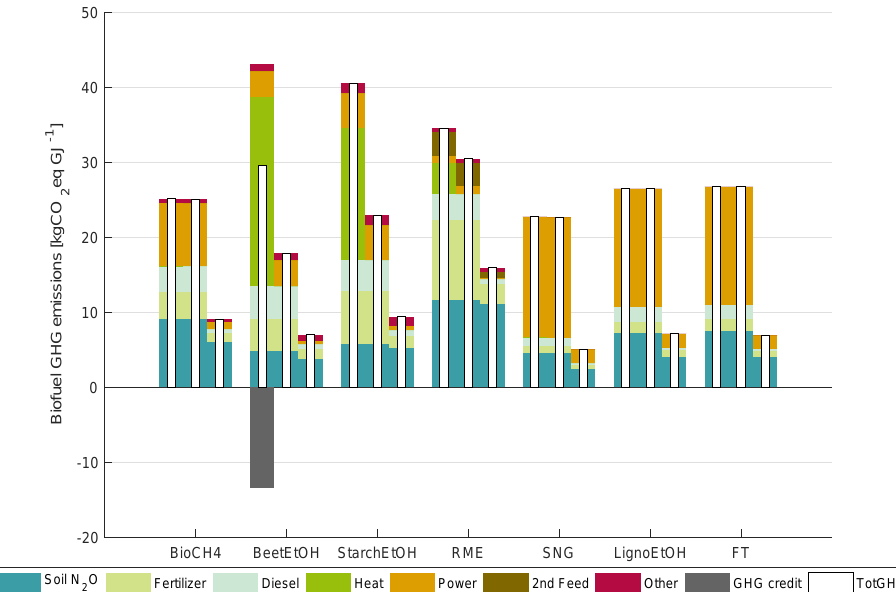
Figure 2. GHG emissions for the biofuel options, broken down to their sources (kgCO 2 eq GJ − 1 ). The leftmost bar for each option is the reference literature case; the middle bar shows the results for the start year of the base case, with renewable heat input; the rightmost bar shows the results for the last year of the base case, where the power mix is cleaner, yields and conversions efficiencies improved and renewable fuel and fertilizer inputs assumed.